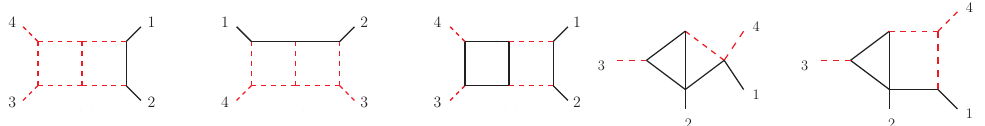
Figure 1: Master integral topologies. Black-solid lines correspond to massive par- ticles, red-dashed lines correspond to massless particles. This figure is from [ 13 ] licensed under CC-BY